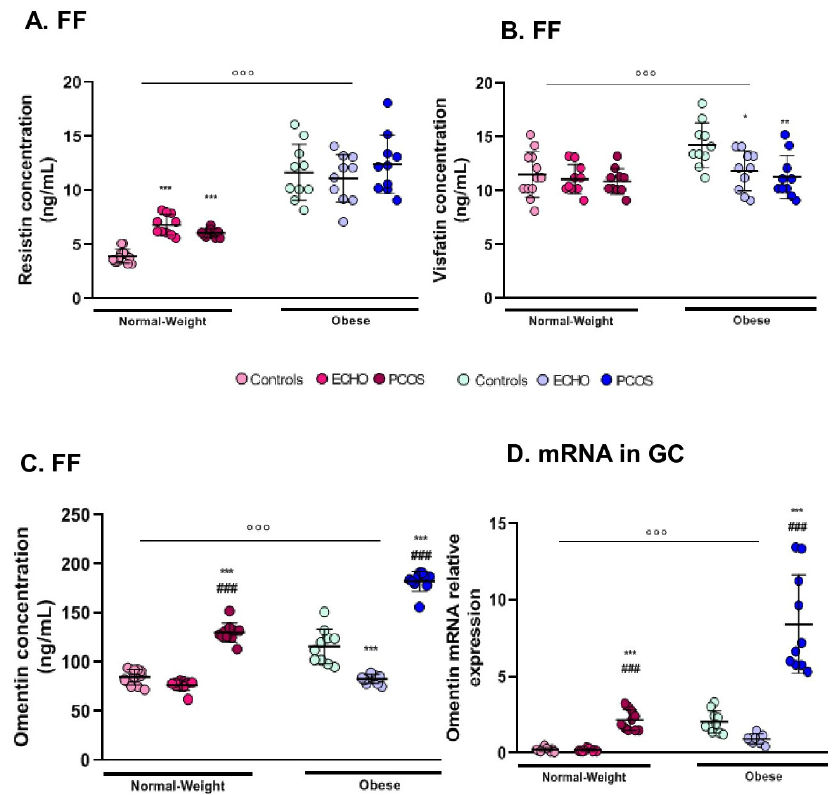
Figure 3. Follicular fluid resistin, visfatin, and omentin concentration and mRNA expression of omentin in granulosa cells of obese and normal - weight PCOS, ECHO, and control groups. (A) Follicular fluid (FF) resistin, ( B ) visfatin, and ( C ) omentin concentrations assessed by ELISA; ( D ) mRNA omentin levels in granulosa cells (GCs) quantified by RT - PCR within the six different groups. The values are expressed as mean ± standard errors of means ( n = 12 for normal - weight controls, n = 13 for normal - weight ECHO, n = 13 for normal - weight PCOS, n = 15 for obese controls, n = 15 for obese ECHO, and n = 10 for obese PCOS). °°° indicates significant difference ( p < 0.001) between normal - weight and obese subjects; * indicates significant difference vs. controls (* p < 0.05, ** p < 0.01, *** p < 0.001); ### indicates significant difference ( p < 0.001) vs. ECHO women.